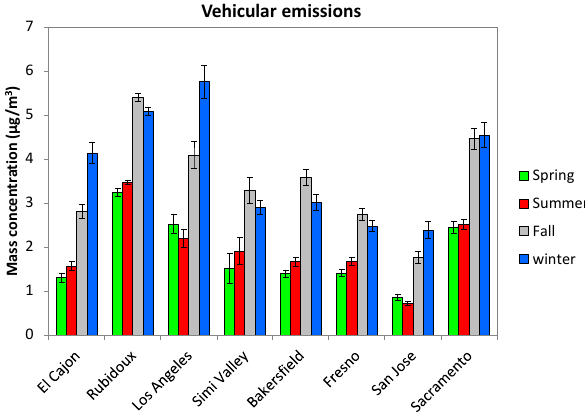
Figure 2. Seasonal average source contribution (µg/m 3 ) of vehicular emissions to ambient PM 2.5, by site. Error bars correspond to one standard error.